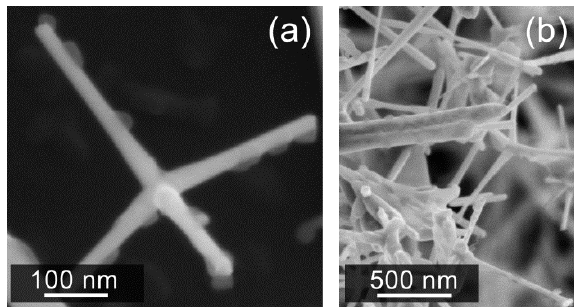
Figure 3. SEM images of ZnO-TPs+TiOPc samples: ( a ) a single ZnO-TP with TiOPc spots;